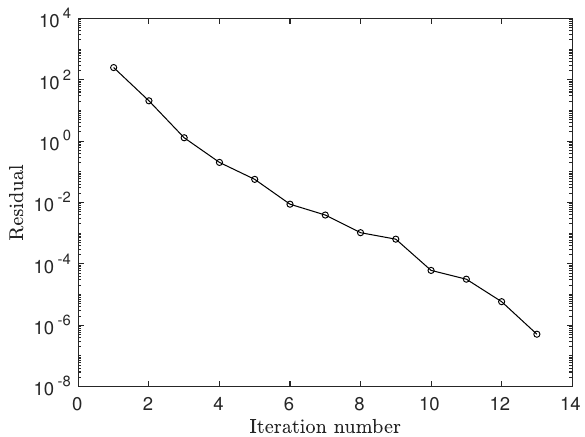
Figure 6. Convergence of the Multiple-Shooting Shadowing (MSS) algorithm for the Lorenz-96 system. The MSS was conducted on K = 35 time segments on a trajectory of total length T = 50, for N = 40 and F =